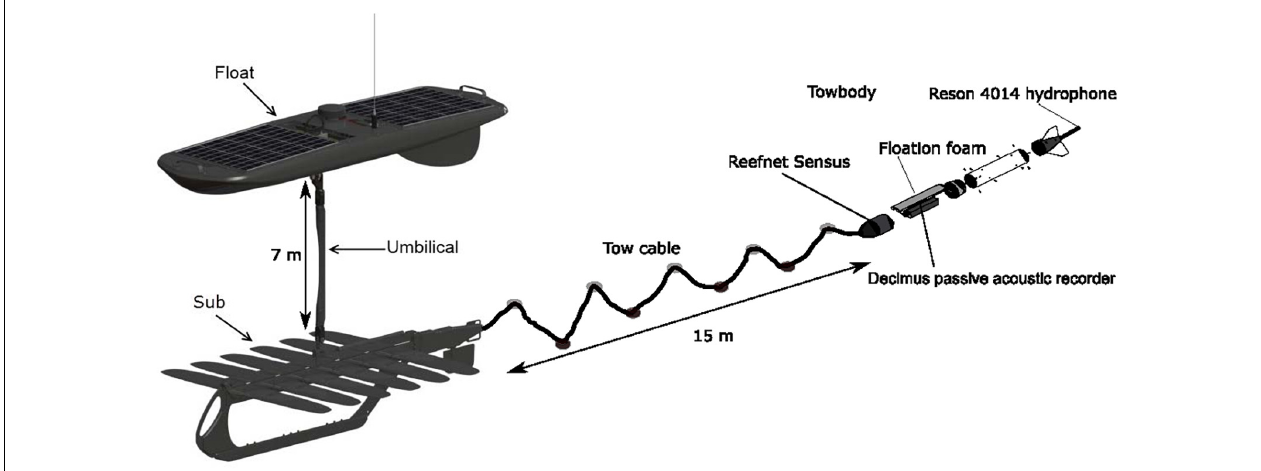
FIGURE 1 | A diagram of the Acoustic Wave Glider (AWG), “Blackbeard,” showing the arrangement of instruments on the float (GPS and satellite antennae, solar panels, AIS antenna, weather station on mast, command and control box, fluorometer, acoustic doppler current profiler, and wave sensor), 7 m long umbilical, and glider instrumentation (CTD and acoustic tag receiver). The passive acoustic recorder and hydrophone system (Decimus) were towed on a 10 m cable with alternating floats and weights that help isolate the recording system from glider-generated